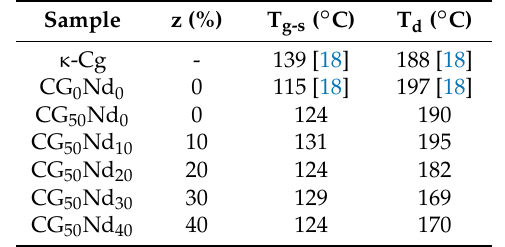
Table 1. Gel-sol transition temperature (T g-s ) and decomposition temperature (T d ) of the CG 50 Nd z